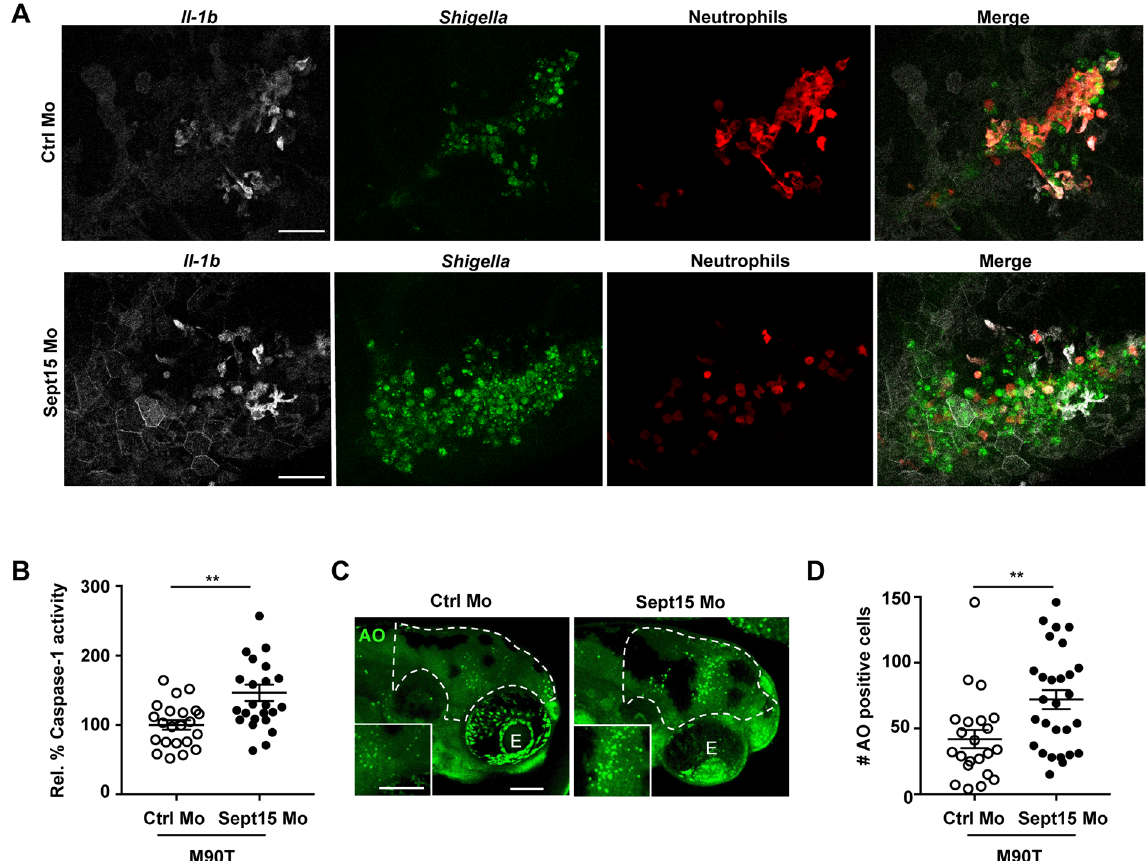
Fig 4. Sept15 restrictsthe inflammatory response in vivo . A. Representative frames extracted from in vivo time-lapse confocal imagingof Tg( il-1b :GFP-F) x Tg( lyz :dsRed) larvae (3 dpf) injectedwith Ctrl or Sept15 Mo and infected in the HBV with Crimson- S . flexneri M90T (low dose) at 19 hpi. Maximum intensity Z-projection images (2 μ m serial optical sections) are shown. Scale bars, 50 μ m. See also S8 and S9 Videos. B. Relative% of Caspase-1 activity levels measured in Ctrl and Sept15 morphants infected for 6 h with ~5 x 10 3 CFU of S . flexneri M90T. Mean ± SEMfrom 3 independentexperiments per treatment using 5–10 larvae per experimental group. Significance testing performed by Student’s t test. ** ; P < 0.01.C. Representative images of Ctrl and Sept15 morphants (Mo) infected with S . flexneri M90T in the HBV and stained for acridineorange.Dotted line shows the area where cells were quantified(i.e. the infected HBV). Scale bars, 100 μ m. E, eye. D. Number of acridine orange(AO) positive cells countedin the HBV of Ctrl or Sept15 morphants 6 hpi with S . flexneri M90T. Significance testing performed by Student’s t test. ** , P < 0.001.Pooled data from 3 independentexperiments per treatment using at least 6 larvae per